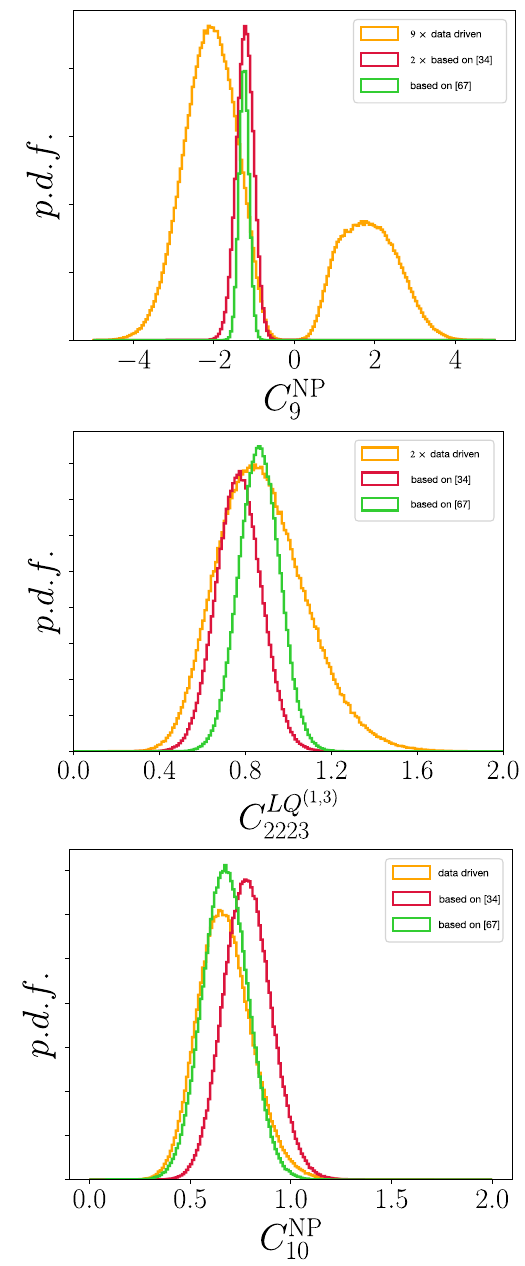
Fig. 4 Probability density function (p.d.f.) for C NP (first panel), C LQ 2223 9 (second panel) and C NP (third panel). Green, red and orange p.d.f.’s 10 correspond to the model-dependent approach from Ref. [71], to the one from Ref. [38], and to the data-driven